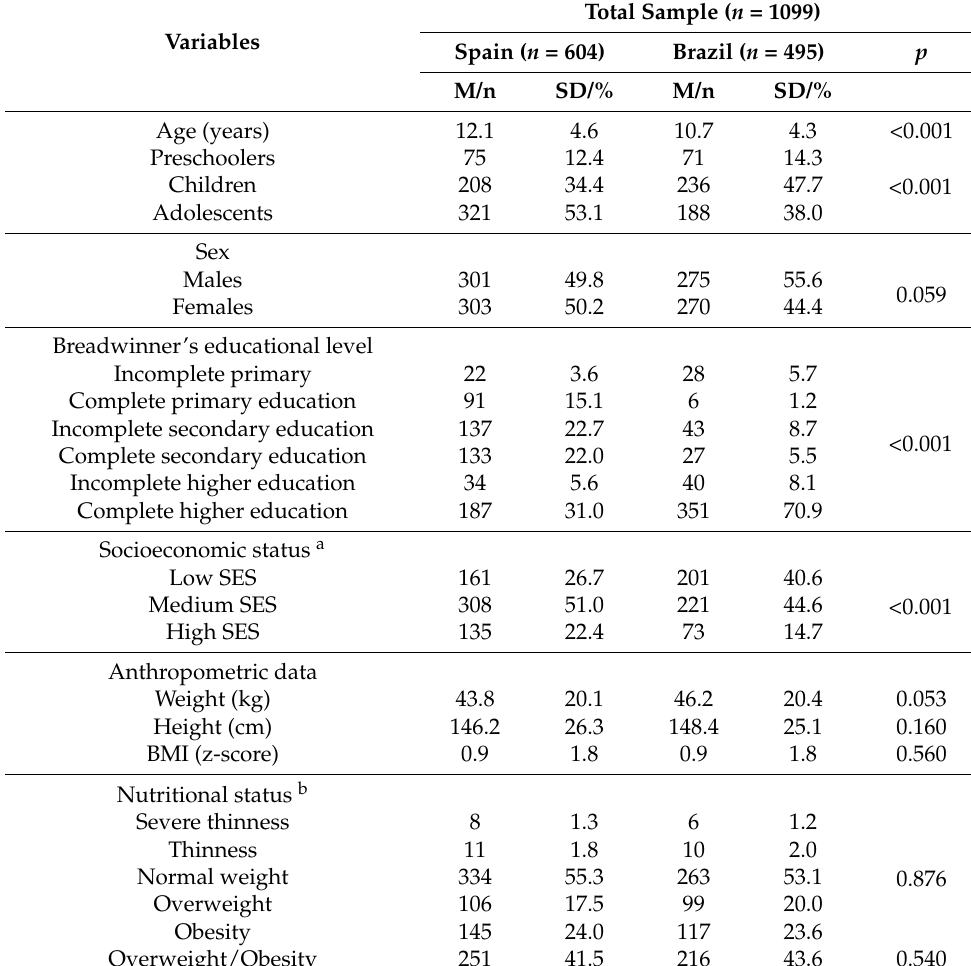
Table 1. Descriptive characteristics of the